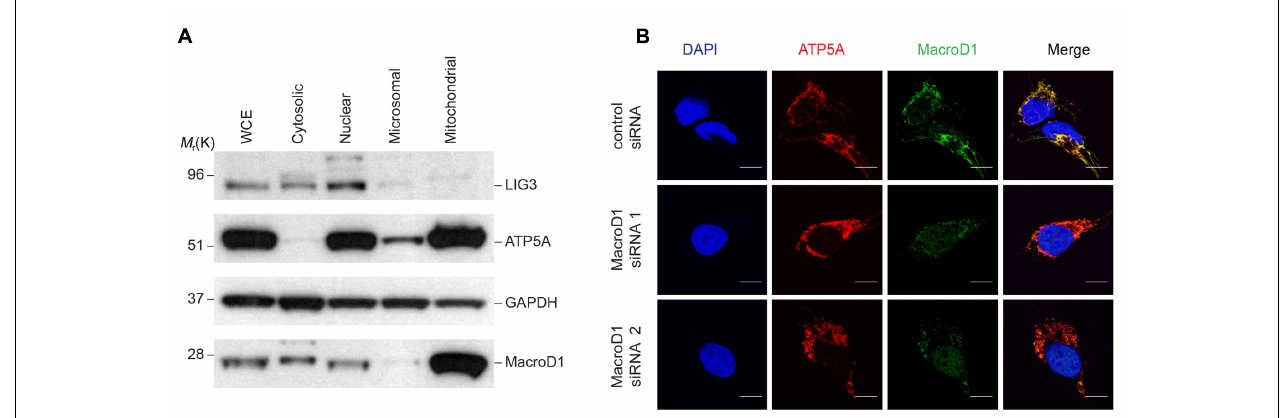
FIGURE 2 | Endogenous MacroD1 localizes to mitochondria. (A) Immunoblot analysis of endogenous MacroD1 protein in whole cell extracts (WCE) and cytosolic [glyceraldehyde 3-phosphate dehydrogenase (GAPDH)], nuclear [DNA ligase 3 (LIG3)], microsomal and mitochondrial [ATP synthase, H+ transporting, mitochondrial F1 complex, alpha subunit 1, cardiac muscle (ATP5A)] sub-cellular fractions from HeLa cells. (B) Indirect immunofluorescence imaging of RD cells following 96 h MacroD1 gene silencing by control siRNA, MacroD1 siRNA 1 or MacroD1 siRNA 2 co-stained with MacroD1 (green), ATP5A (red), and DAPI (blue). Scale bar = 10 µ